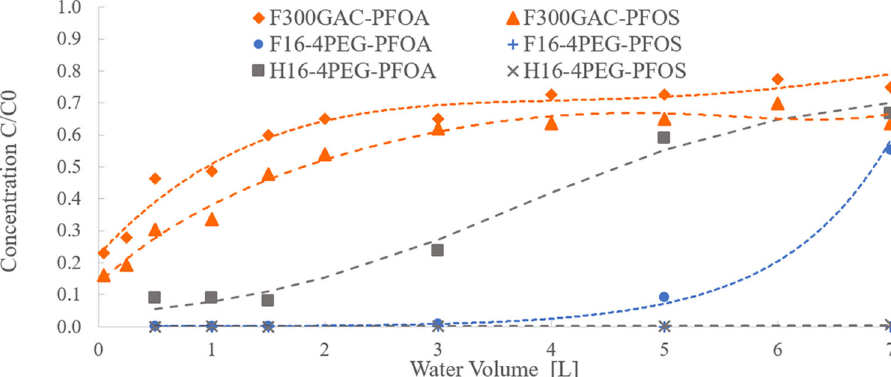
Fig. 3 Dynamic fi ltration breakthrough results. PFOA and PFOS breakthrough data showing C/C 0 for each fi lter substrate. Curves are guides for the eye. For the F300GAC errors are estimated to be 50% for both PFOA and PFOS. For the F16-4PEG fi lter errors are estimated to be 50% for PFOA and smaller than the symbol size for PFOS. For H16-4PEG the errors are estimated to be 50% before breakthrough of PFOA rising to 80% after breakthrough, and smaller than the symbol size for PFOS.